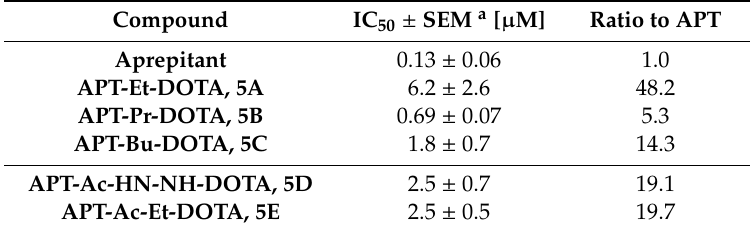
Table 4. Binding a ffi nity of aprepitant and compounds 5A – E for the rat neurokinin 1